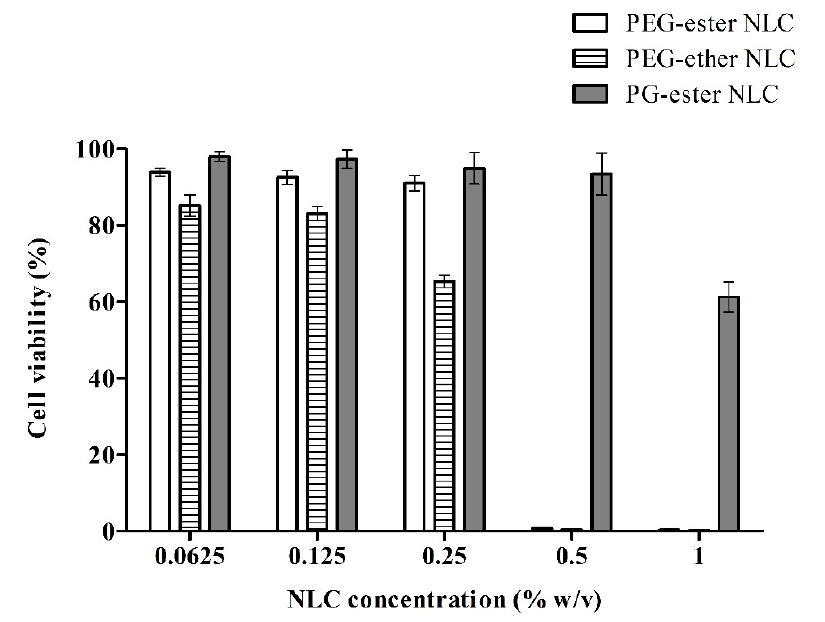
Figure 3. Viability of Caco-2 cells after 4 h incubation with INS-SDS complex loaded NLCs at indicated concentrations determined via resazurin assay. Samples were prepared in 25 mM HBS (HEPES buffered saline) pH 7.4. HBS only was used as a positive control, and Triton X-100 (0.2%, v/v) in HBS was used as a negative control for cell viability. Data are shown as means ± SD ( n = 3).